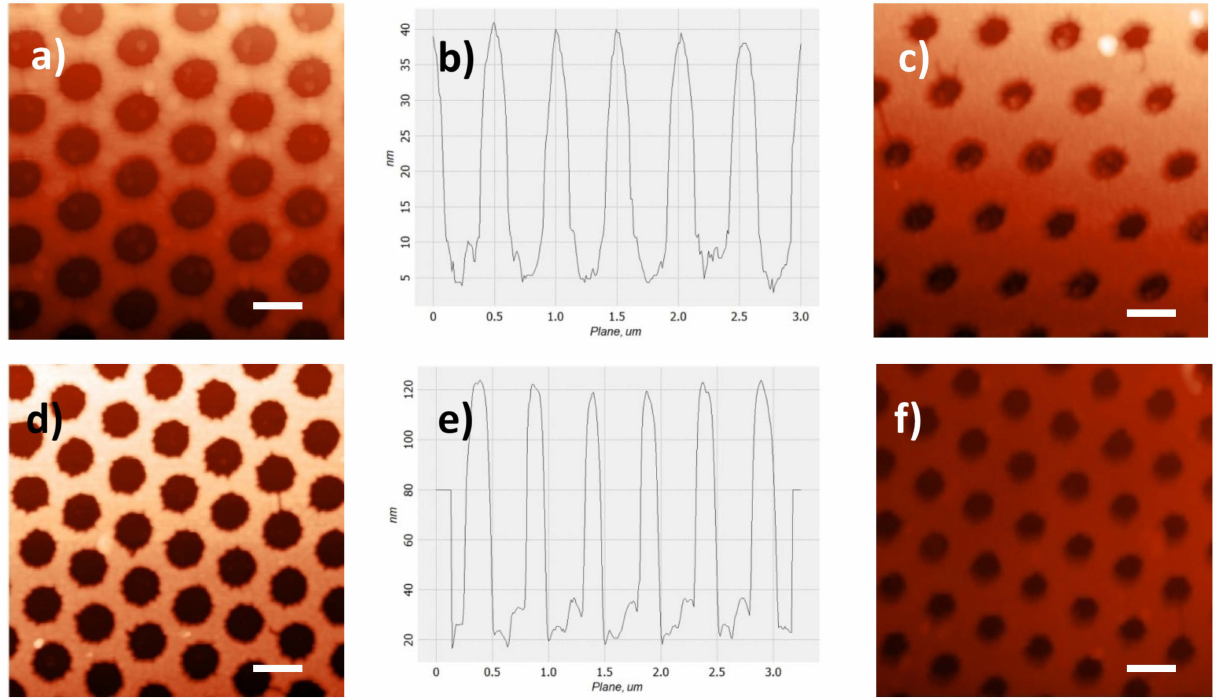
Figure 2. Atomic force microscopy height topographic images of the four types of samples with diameters of ( a ) (350 ± 20) nm, ( c ) (240 ± 20) nm, ( d ) (320 ± 20) nm, and ( f ) (230 ± 20) nm. ( b , e ) The topographic image profiles that show the height of the gold film: 30 nm for the samples in ( a , c ) images, 100 nm in ( d , f ) images. Scale bars: 500